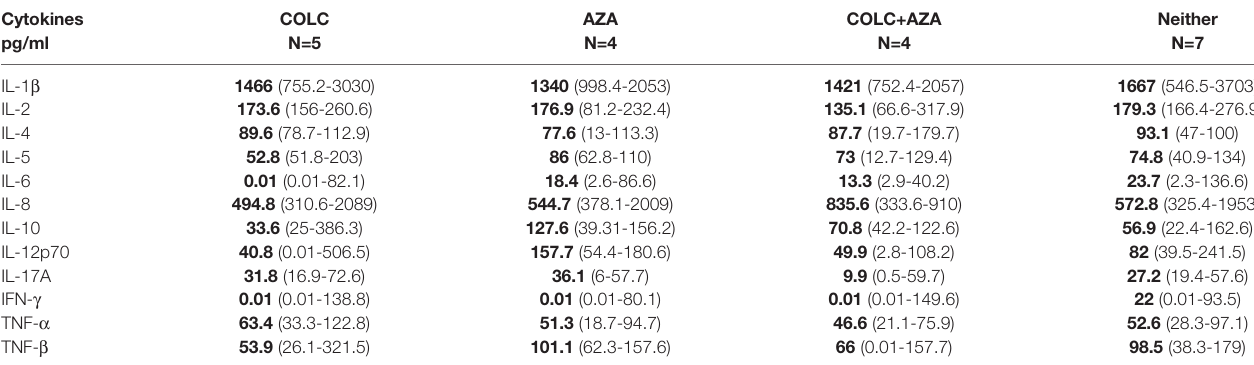
TABLE 4B | Saliva cytokine concentrations from Behc ̧ et ’ s Disease (BD) patients taking colchicine (COLC) and/or Azathioprine (AZA). Cytokines COLC AZA COLC+AZA Neither pg/ml N=5 N=4 N=4 N=7 IL-1